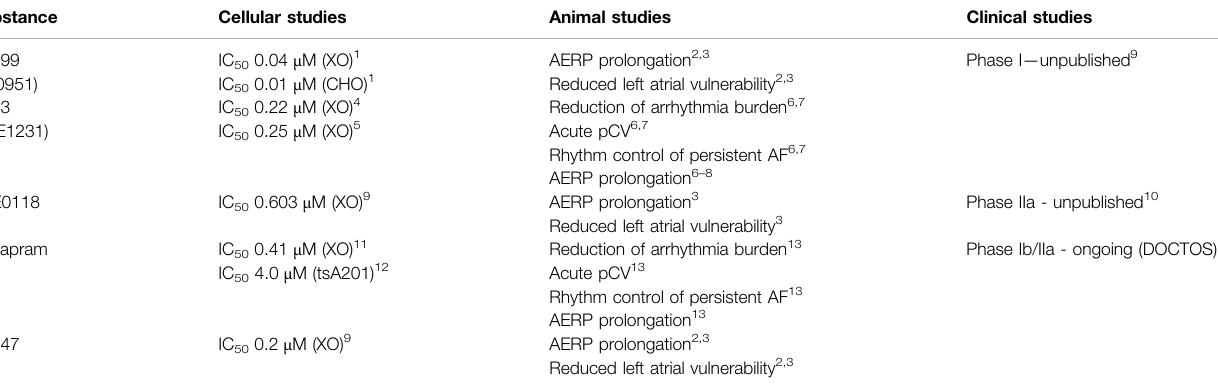
TABLE 2 | List of TASK-1 inhibitors that have been tested in animal or human studies for their possible use in atrial fi brillation treatment. For IC 50 value measurement the humanTASK-1 channel has been heterogeneously expressed in Xenopus laevis oocytes (XO), chinese hamster ovarian cells (CHO) or human embryonic kidney cells (tsA201). For the IC 50 measurements of doxapram in X. leavis oocytes ratTASK-1 has been used, no measurements with hu manTASK-1 in oocytes are